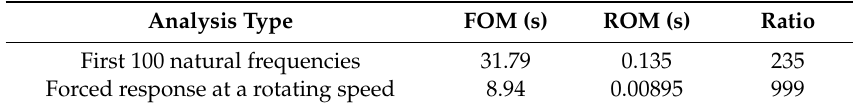
Comparison on the computational e ffi ciency between full-order model (FOM) and reduced-order model